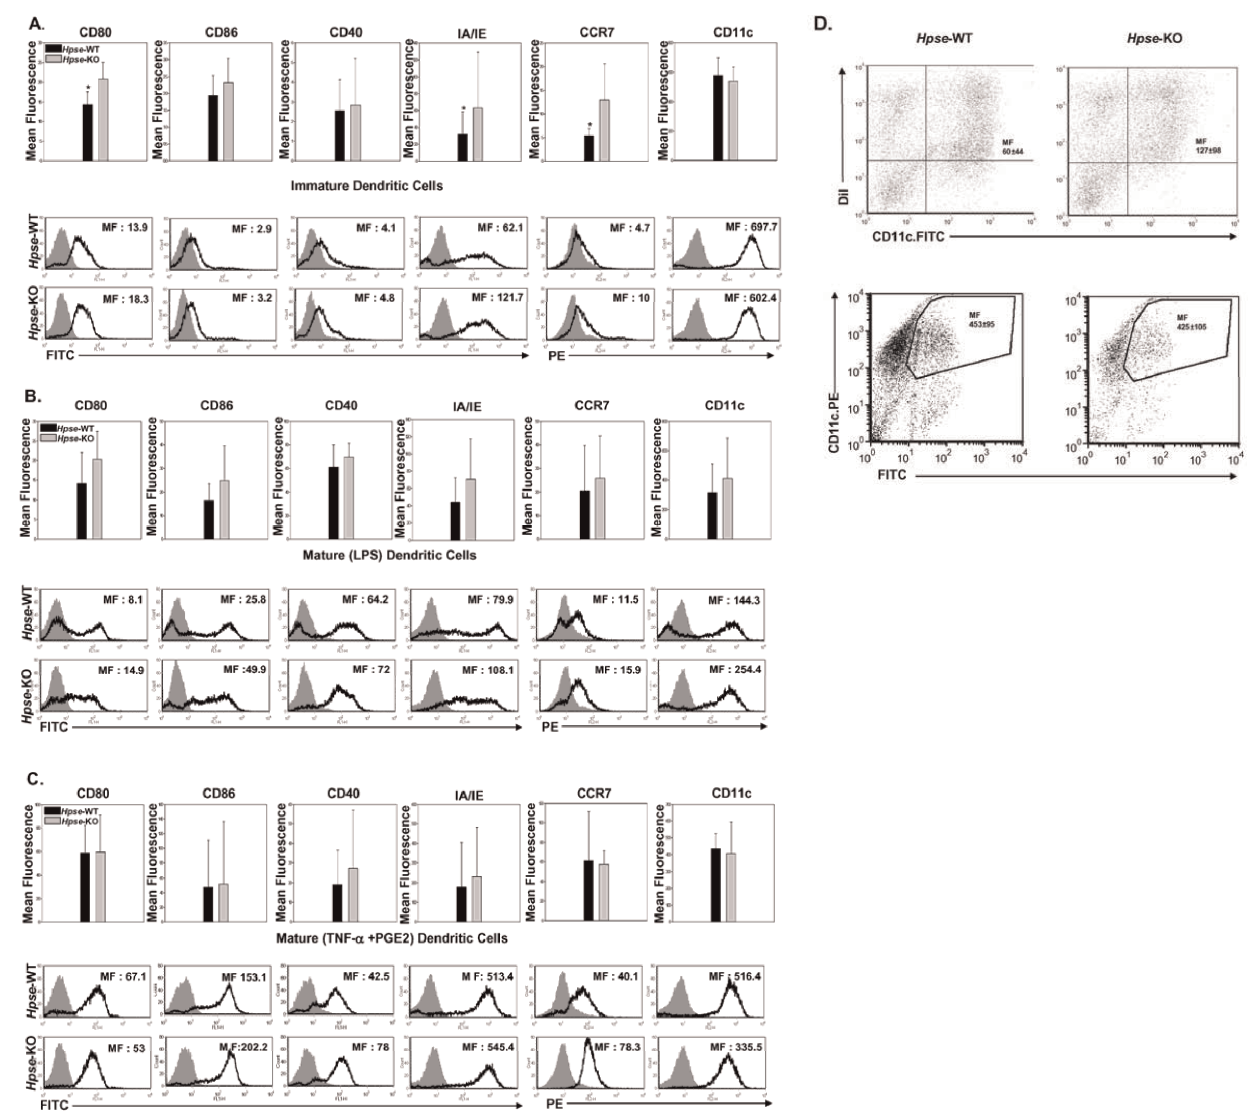
Figure 3. BMDCs from Hpse -KO mice have a phenotype with increased expression of maturation molecules and CCR7, and phagocytose apoptotic cells more efficiently. A , B , and C . (A) iBMDCs and ( B ) mBMDCs matured with LPS, and ( C ) mBMDCs matured with mTNF a + PGE2, from Hpse- WT and Hpse -KO mice, are stained for CD80, CD86, CD40, IA/IE, CCR7, and CD11c (black line), and for isotype control of each marker (gray-filled curves). Mean fluorescence (MF) is the average of five experiments. Asterisk indicates p , 0.02, t-test. D. Uptake of apoptotic cells and FITC-labeled beads by iBMDC from Hpse- WT and Hpse -KO mice. Upper panel. Apoptotic cells were stained with DiI before the interaction with iBMDCs. 2 hours after the interaction with apoptotic cells, iBMDCs were stained with CD11c.FITC. Mean fluorescence (MF) of double positive